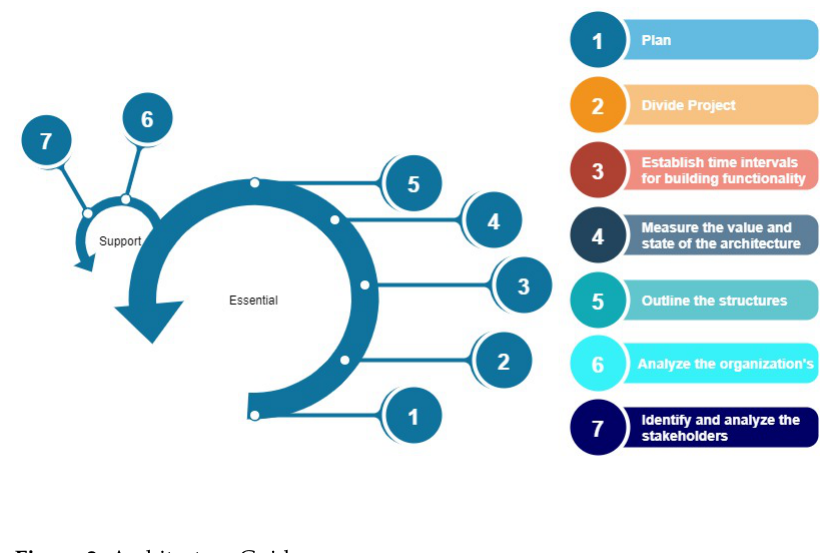
Figure 2. Architecture